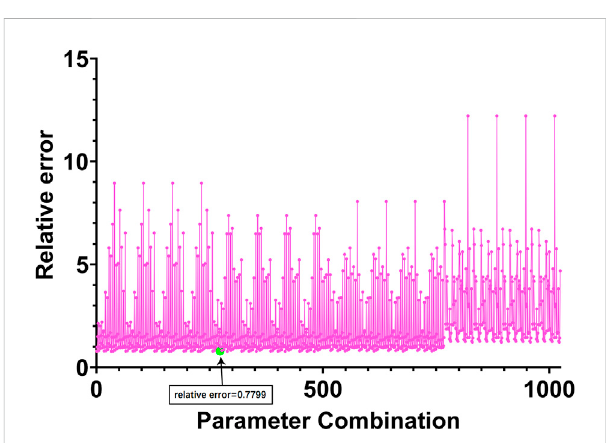
FIGURE 3 Relative errors corresponding to different parameter combinations. The horizontal coordinate in the fi gure represents 1024 parameter combinations, and the vertical coordinate represents the index to measure the performance of the algorithm proposed in Eq. 11 in Section